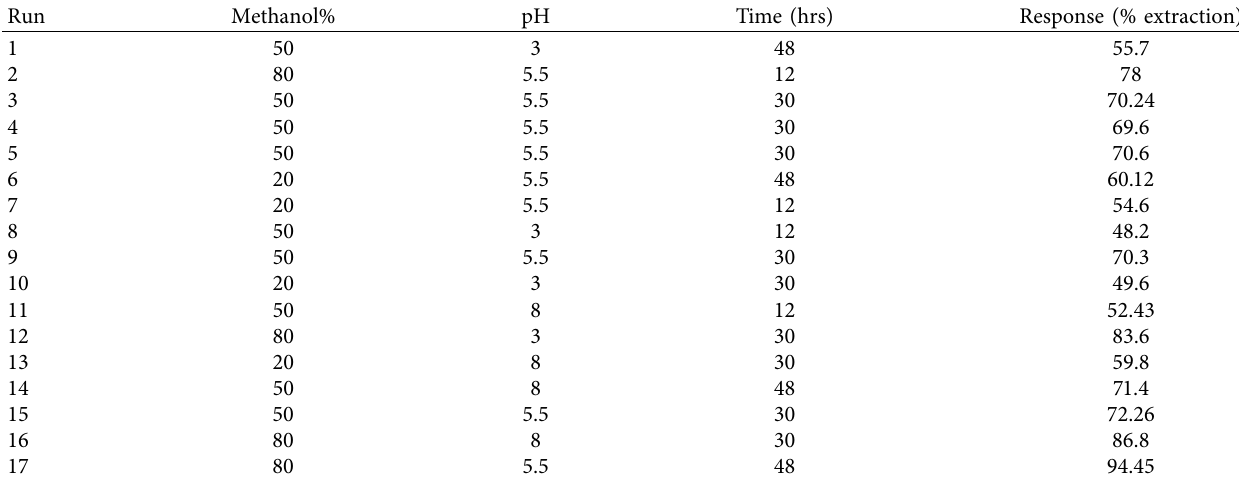
Table 3: Designed variables and the response using BBD.